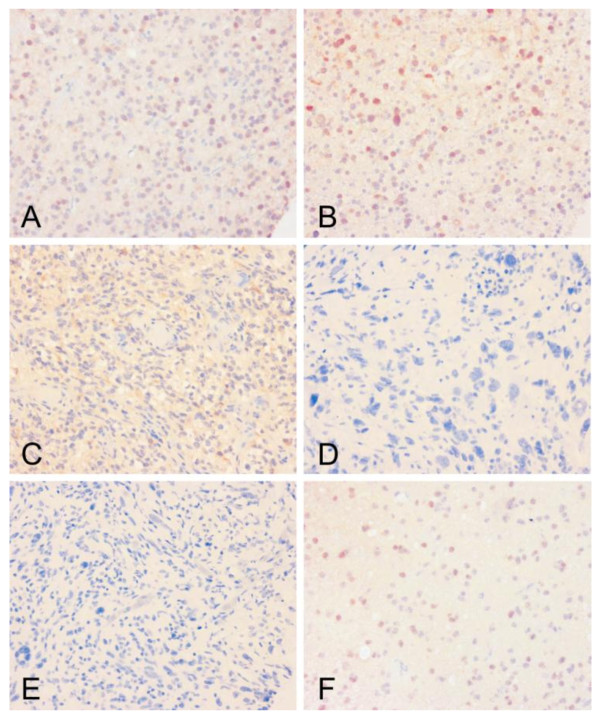
Expression of peroxiredoxins I-VI in astrocytic brain tumors. Positive expression is seen as an immunohistological red staining in nucleus of the astrocytoma cells (Prx I, A; Prx II, B and Prx VI, F) and in the cytoplasma (Prx III, C). Prx IV (D) and Prx V (E) stainings are negative. The figure panel consist astrocytic brain tumors of various grades (grade II, B, F; grade III A, grade IV (gbm) C, D, E).